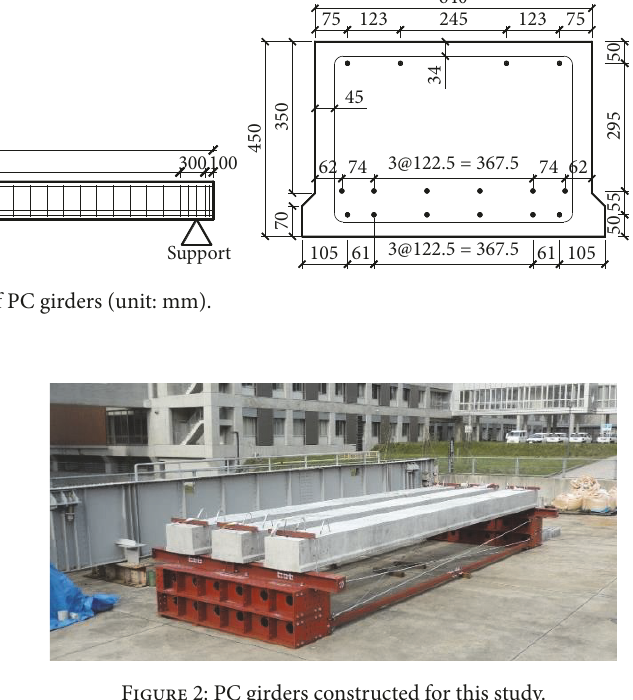
Figure 2: PC girders constructed for this